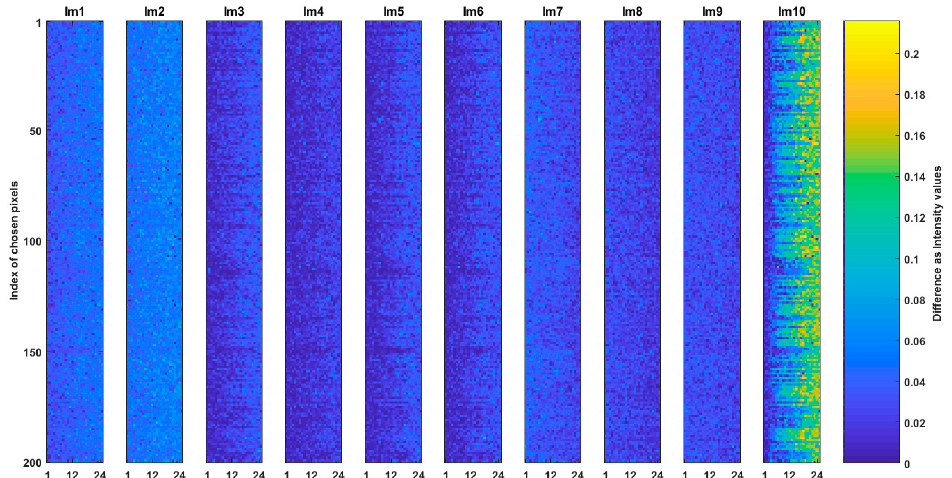
Figure 7. Comparison of CSE_sq and CSE_Hex. The absolute intensity value difference of ten SQ CEorg and Hex _ E CEorg are shown.